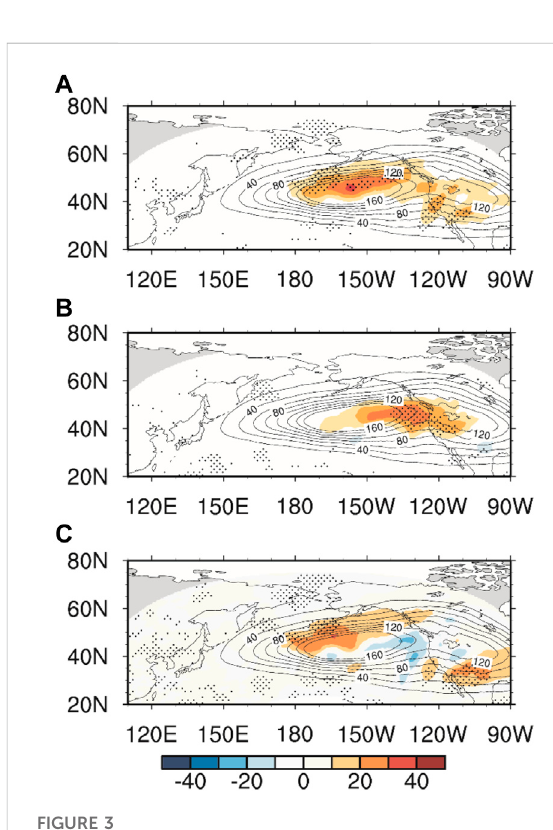
Numerical simulations of 850 hPa meridional transient eddy heat fl ux (K m s − 1 , shading) in the cold season. (A) Response of 850 hPa meridional eddy heat fl ux to KE-related mesoscale SSTAs (KSTS-MEFS). (B) The same as (A) but for KE-related large- scale SSTAs (MEFS-CTRL). (C) The differences in the response of transient eddy heat fl ux to KE-related mesoscale SSTAs and the response of transient eddy heat fl ux to KE-related large-scale SSTAs. The isoline is the climatological meridional transient eddy heat fl ux simulated by the model (CTRL). Statistically signi fi cant differences at 90% according to Student ’ s t test are